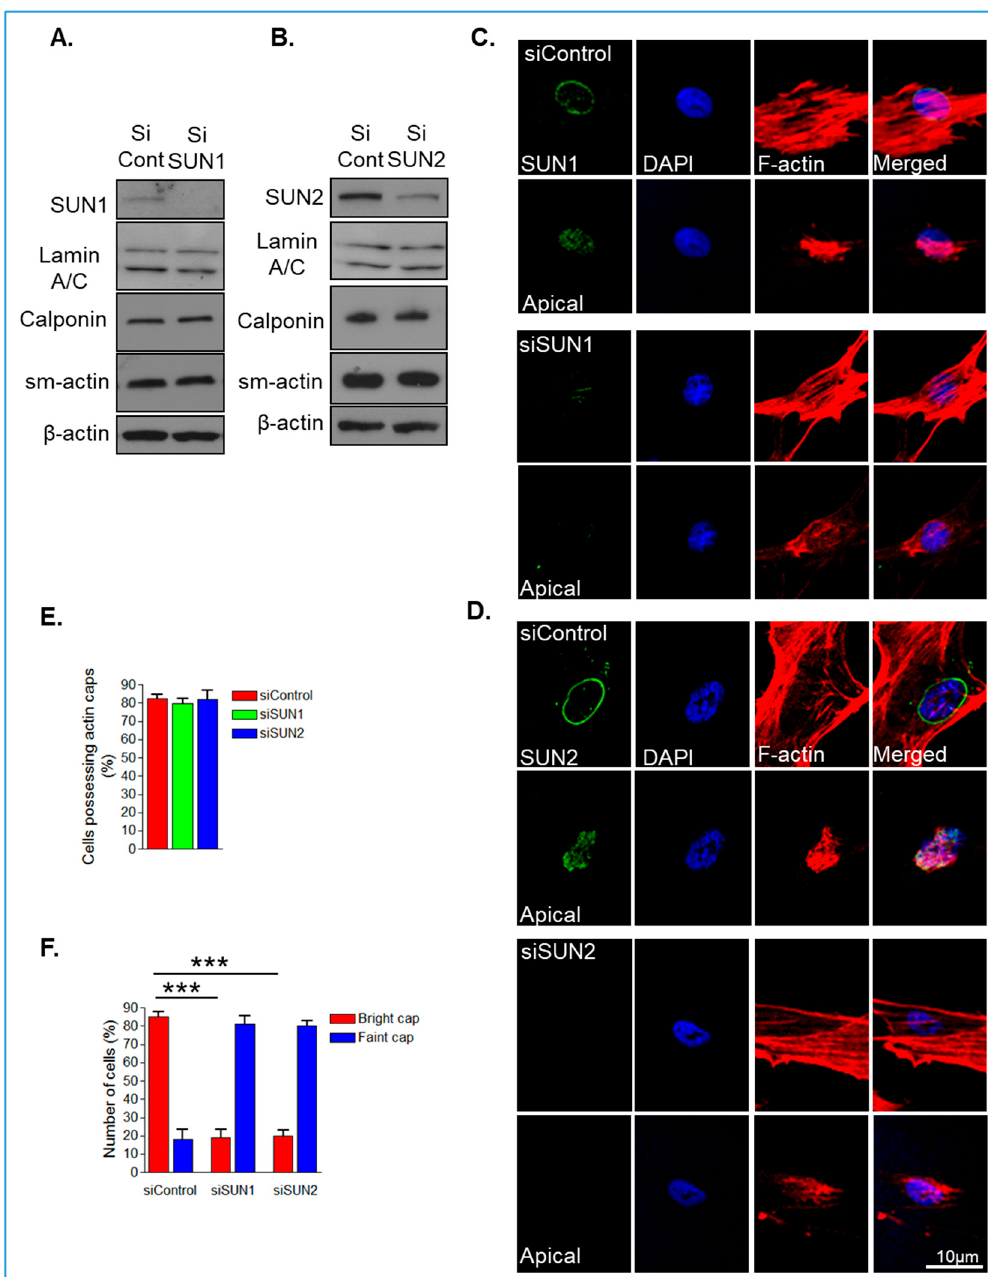
Figure 1. SUN1 or SUN2 depletion induces actin cap reorganisation. Western blotting (WB) of ( A ) SUN1- and ( B ) SUN2-depleted vascular smooth muscle cells (VSMC) lysates. Confocal immunofluorescence analysis imaging the apical and middle sections of F-actin (red), SUN1 or SUN2 (green), and DAPI (blue) stained ( C ) control and SUN1-depleted and ( D ) control and SUN2-depleted VSMCs grown on 12 kPa hydrogels. Graphs show ( E ) number of VSMC possessing actin caps and ( F ) the number of VSMCs possessing bright or faint actin cap staining displayed by control, SUN1- and SUN2-depleted VSMCs grown on 12 kPa hydrogels. Graphs represent the combined data from three independent experiments analysing > 20 cells (*** p < 0.0001).